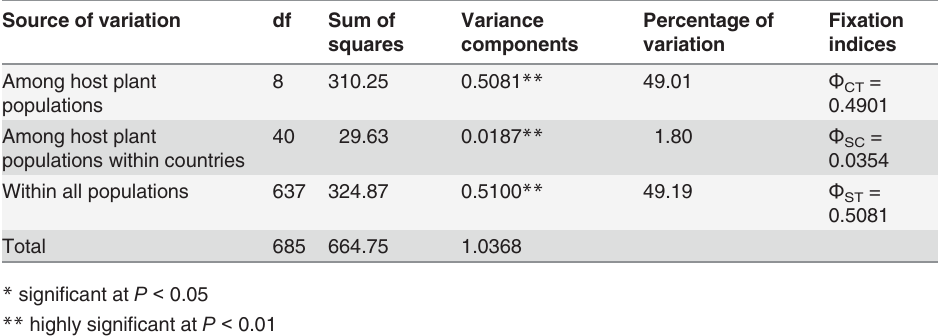
Variance Percentage of Fixation squares components variation indices